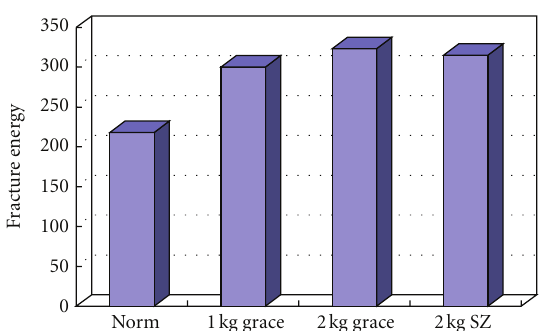
Figure 14: Cracking energy comparison.